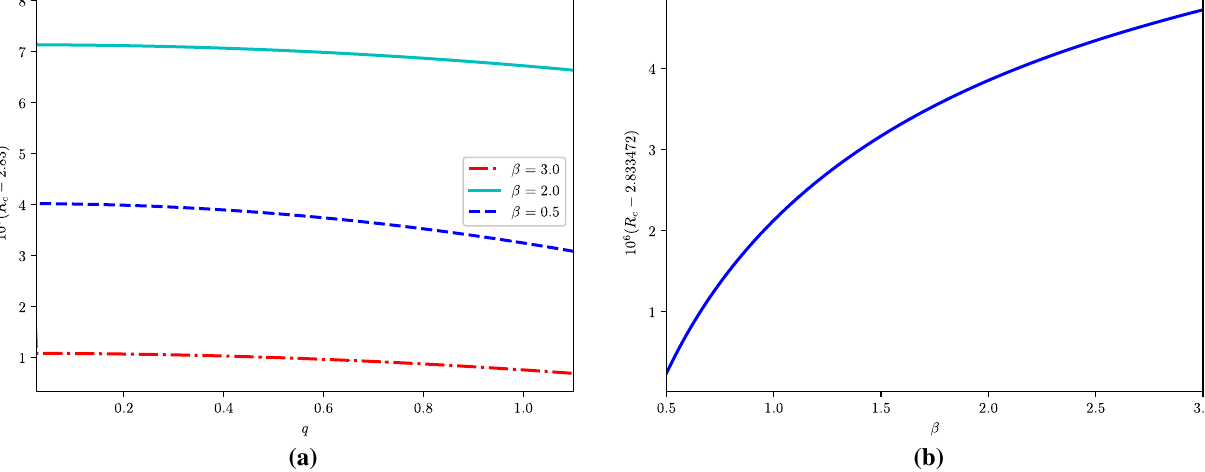
Fig. 6 Homogeneous sphere source: the dependence of the radius of screening with a precision of 0.9 on a the charge q and b the strength of √ self-interaction β (for q = 0 . 1). In both cases, R s = 1 /